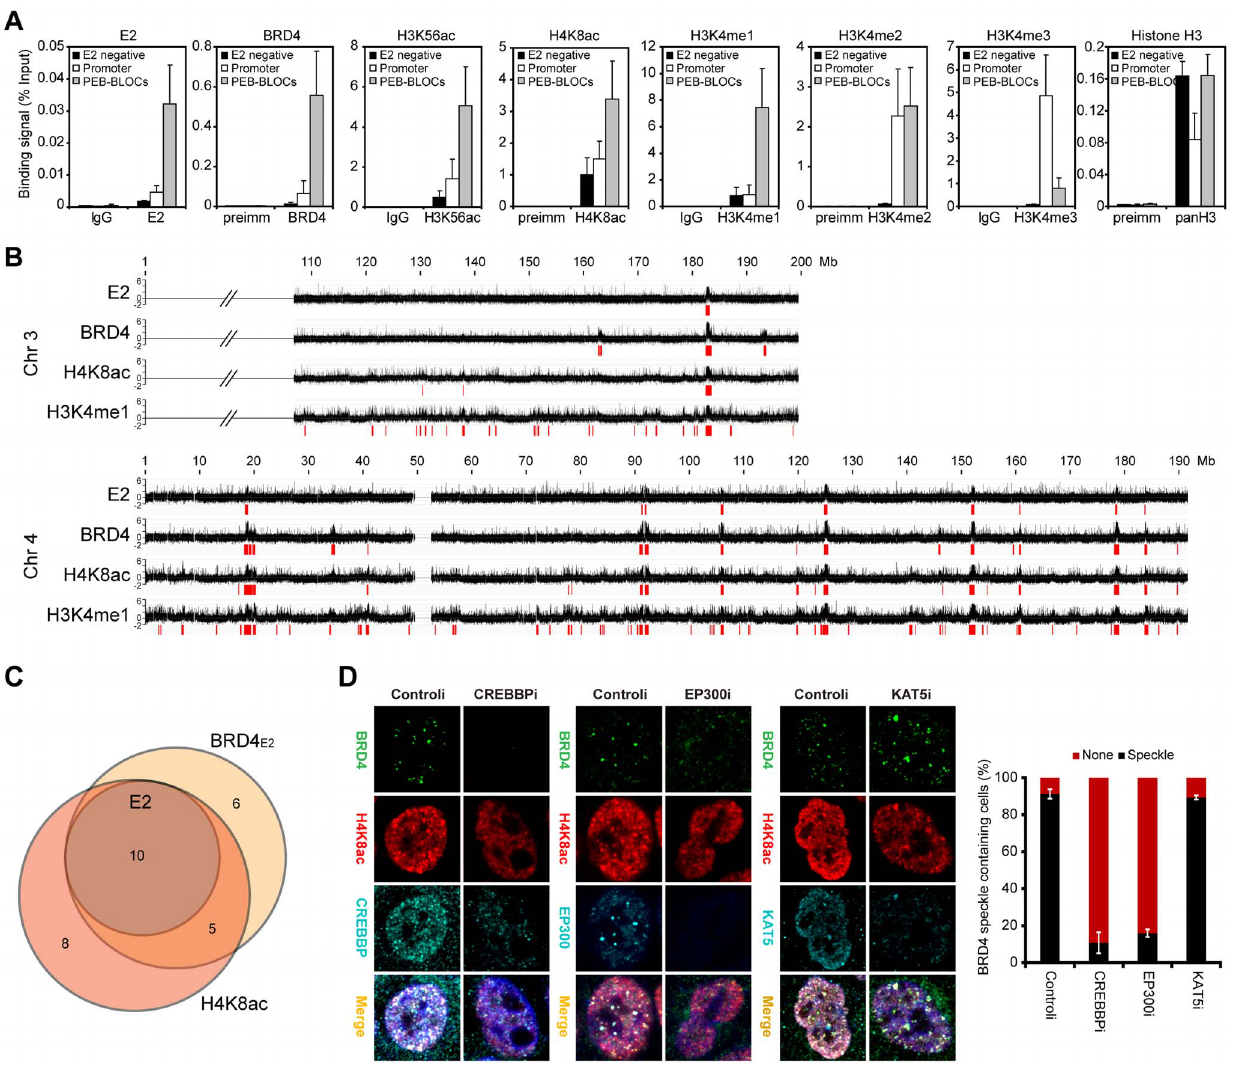
Figure 4. Persistent E2 binding correlates with histone acetylation through CREBBP/EP300 HAT activity. A. Mitotic chromatin was isolated from C-33-1E2 cells and immunoprecipitated with control serum or specific antibodies to E2, BRD4, H3K56ac, H4K8ac, H3K4me1, H3K4me2, H3K4me3, and histone H3. ChIP DNA was analyzed by Q-PCR for specific PEB-BLOC regions (listed in Table S9). Average values and STDEV are shown for three independent experiments on four non-E2 binding regions, four active promoters, and six PEB-BLOCs. B. ChIP-chip analysis of E2, BRD4, H4K8ac, and H3K4me1 binding in C-33-1E2 cells. Chromatin was prepared from asynchronous cells and isolated using antibodies against E2, BRD4, acH4K8, and H3Kme14. ChIP DNA was hybridized to one HD microarray chip (Nimblegen). The binding profile for E2, BRD4, and histones on chromosome 3 and 4 is shown. Broad regions of enriched binding were defined computationally and are shown in red and are listed in Table S4. C. Venn diagram showing the overlap among the enriched binding regions defined in B. D. C-33-1E2 cells were treated with CREBBP, EP300 or KAT5 siRNA for 3 days. Cells were stained by immunofluorescence for anti-BRD4 (green), anti-H4K8ac (red), cellular DNA (blue), and anti-CREBBP, -EP300, or -KAT5 antibodies (cyan). The bar chart to the right shows quantification of BRD4 speckle formation in these Interphase cells were analyzed for. Average values and STDEV were calculated for three independent experiments (75–150 cells counted per experiment).